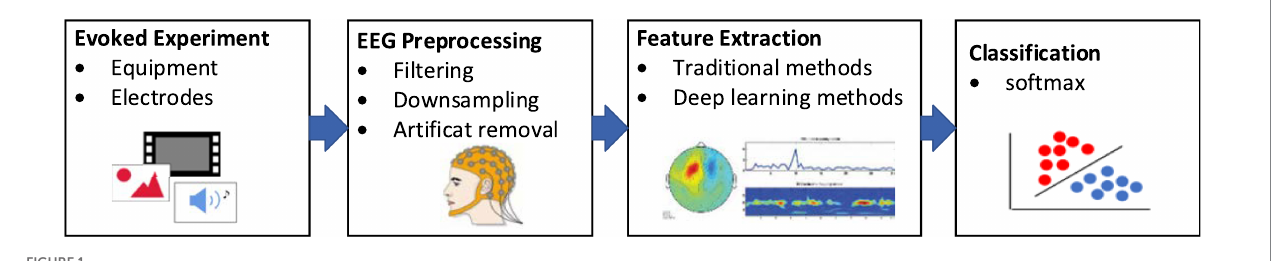
FIGURE 1 Flowchart of emotion recognition using EEG signals.